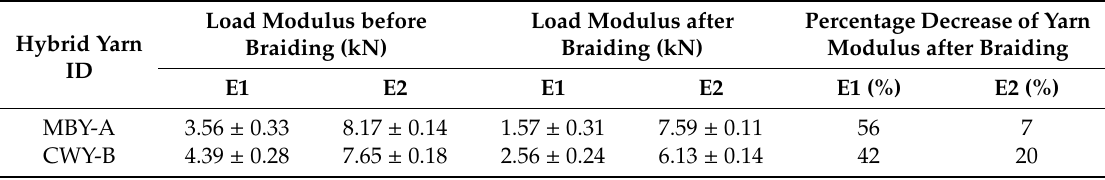
Table 5. Hybrid yarn load modulus (E1 and E2) before and after